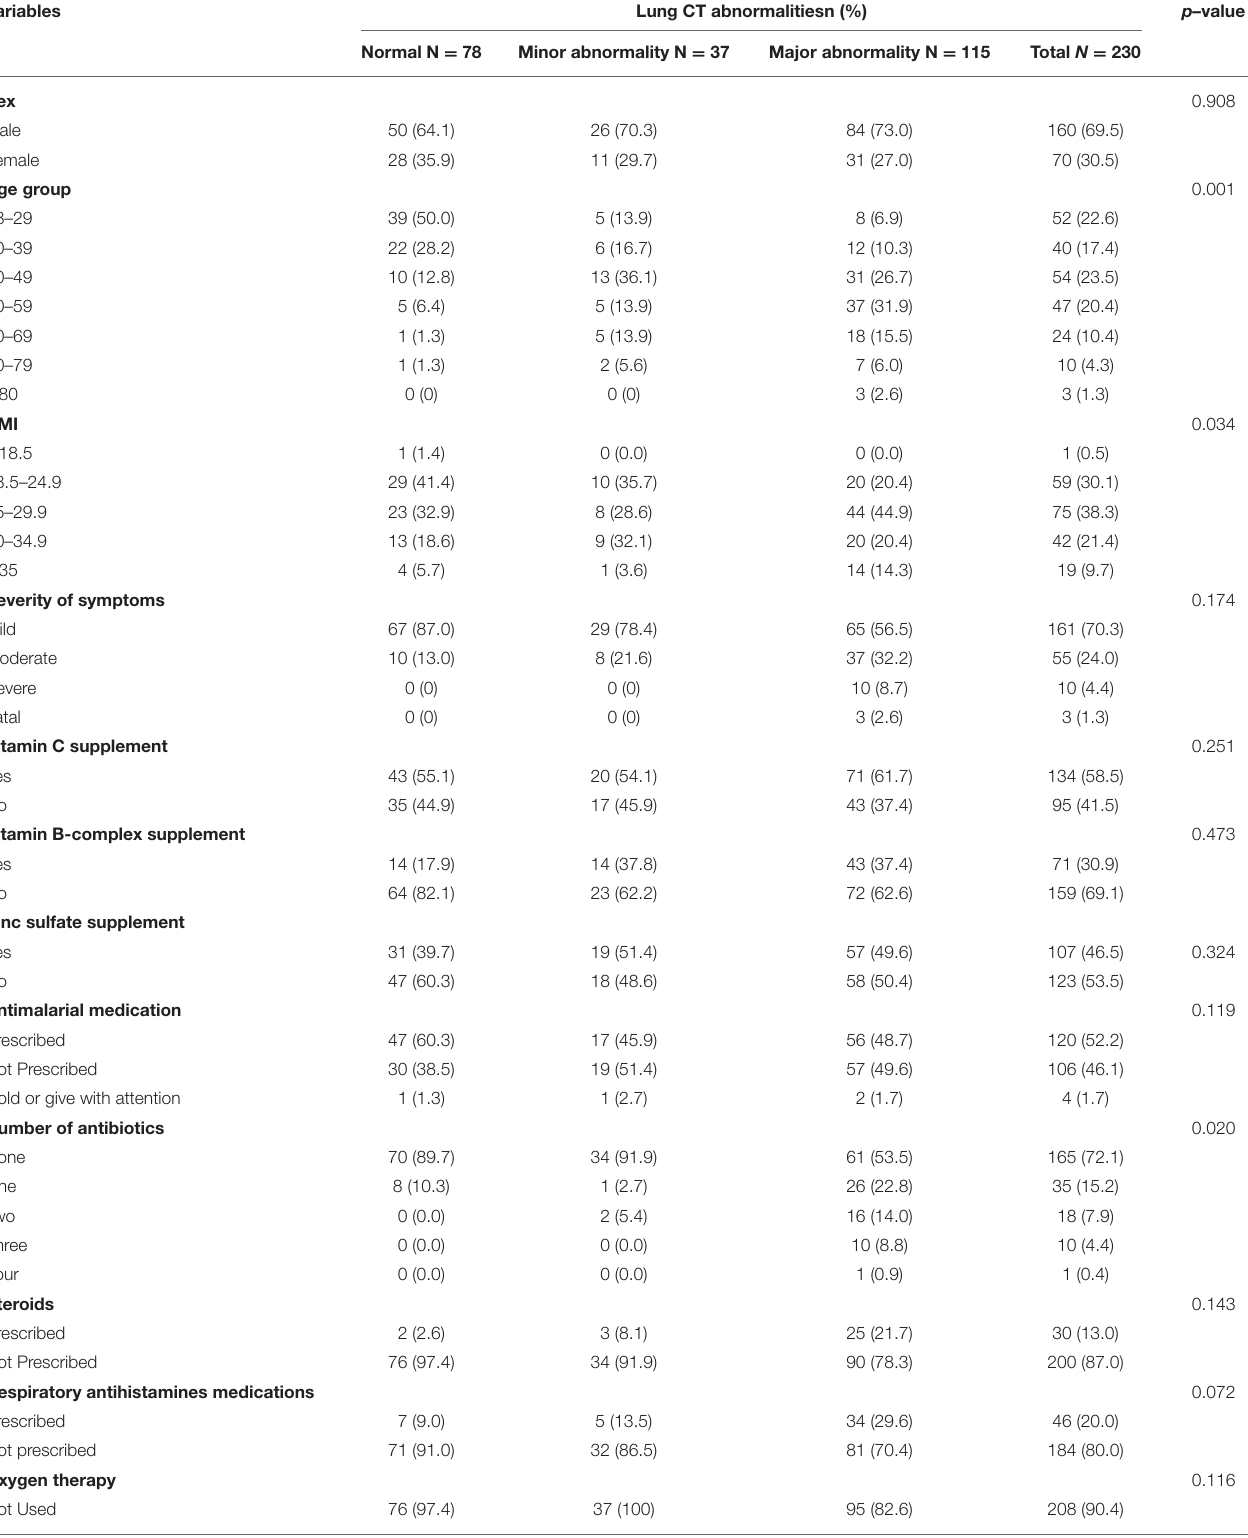
TABLE 1 | Frequencies and percentages of sex, age, and medical variables among the study participants based on lung CT abnormalities.